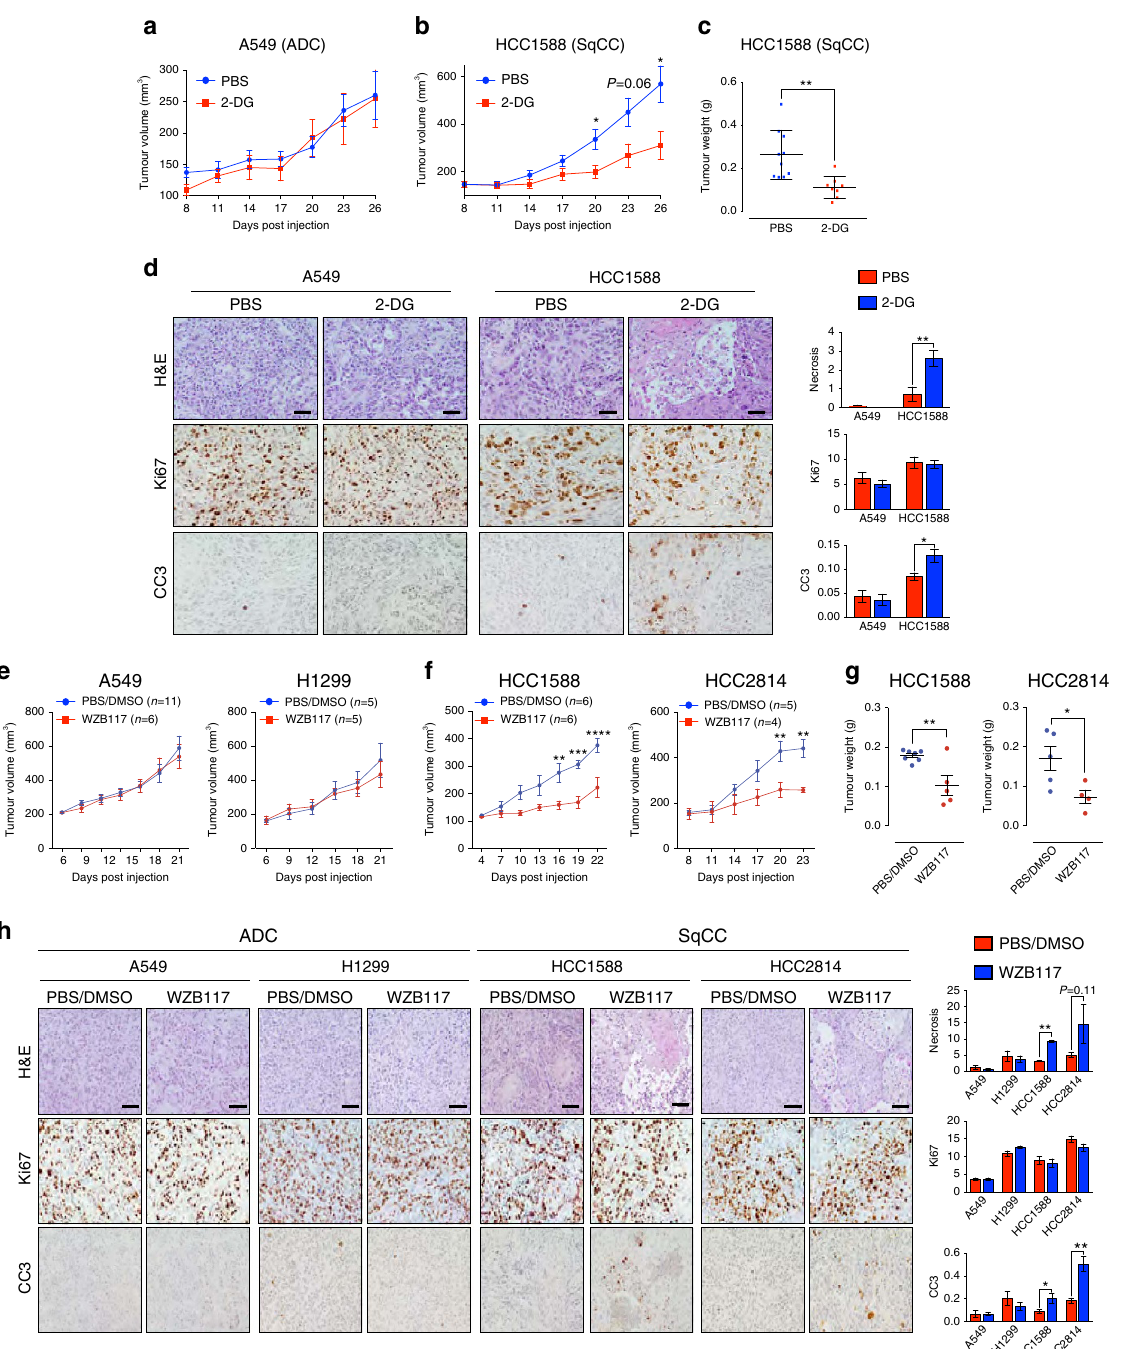
Figure 5 | Lung SqCC is susceptible to glycolytic inhibition. ( a , b ) Xenograft tumour growth of A549 ADC (PBS, n ¼ 9; 2-DG, n ¼ 5; a ) and HCC1588 SqCC (PBS, n ¼ 12; 2-DG, n ¼ 12; b ) treated with PBS as control or glycolytic inhibitor 2-DG (500mgkg (cid:2) 1 , once daily). Two-way ANOVA, * P o 0.05. ( c ) Tumour weights of PBS- or 2-DG-treated xenograft tumours. Two-tailed t -test, ** P o 0.01. ( d ) IHC analysis (left) and quantification of % area (right) of necrosis, proliferative marker Ki67 and cleaved caspase-3 (CC3) in PBS (A549, n ¼ 9; HCC1588, n ¼ 12) or 2-DG (A549, n ¼ 5; HCC1588, n ¼ 12)-treated xenograft tumours. Eight to ten images in each tumour were captured and analysed for quantification. Two-tailed t -test, ** P o 0.01, * P o 0.05. ( e , f ) Xenograft tumour growth of ADC A549 (PBS, n ¼ 11; WZB117, n ¼ 6) and H1299 (PBS, n ¼ 5; WZB118, n ¼ 5; e ) and SqCC HCC1588 (PBS, n ¼ 6; WZB117, n ¼ 6) and HCC2814 (PBS, n ¼ 5; WZB117, n ¼ 4; f ) treated with PBS/DMSO as vehicle or GLUT1 inhibitor, WZB117 (10mgkg (cid:2) 1 , once daily). Two-way ANOVA, **** P o 0.0001, *** P o 0.001, * P o 0.05. ( g ) Tumour weights of PBS/DMSO or WZB117-treated SqCC HCC1588 (left) and HCC2814 (right) xenograft tumours. Two-tailed t -test. ** P o 0.01. ( h ) IHC analysis (left) and quantification of % area (right) of necrosis, proliferative marker Ki67 and CC3 in PBS/ DMSO (A549, n ¼ 11; H1299, n ¼ 5; HCC1588, n ¼ 6; HCC2814, n ¼ 5) or WZB117 (A549, n ¼ 6; H1299, n ¼ 5; HCC1588, n ¼ 5; HCC2814, n ¼ 4)-treated xenograft tumours. Eight to ten images in each tumour were captured and analysed for quantification. Two-tailed t -test. ** P o 0.01, * P o 0.05. All error bars represent the mean ± s.e.m. Scale bars, 100 m m.